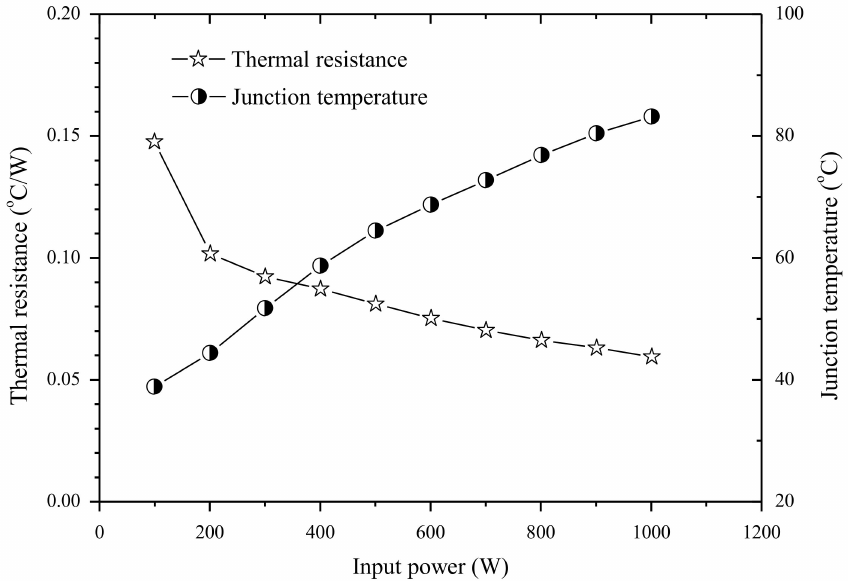
Figure 9. Thermal resistance and junction temperature vs. heating power of the PHP thermal